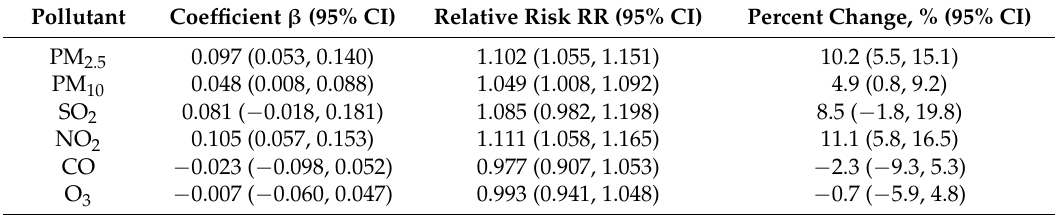
Table 3. Associations between each 1-SD increase of current day air pollution and allergic